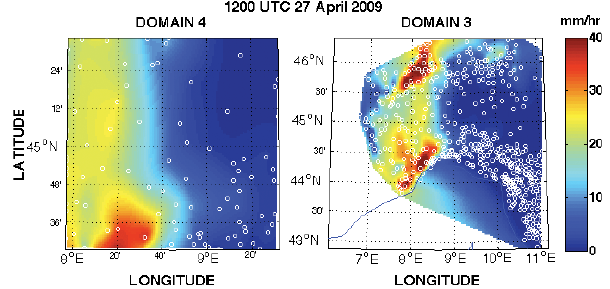
Fig. 2. Rain gauge coverage (white circles) and measured precipita- tion rate (in mmh − 1 ) at 12:00UTC, 27 April, interpolated on MM5 grid points of domain 4 (left panel) and domain 3 (right